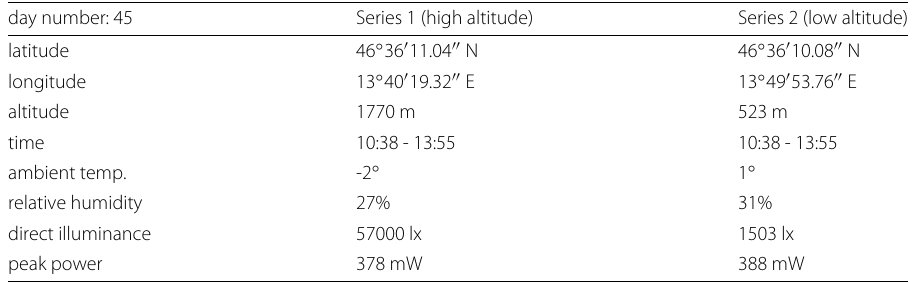
Table 1 Comparison of new experiment conditions and results